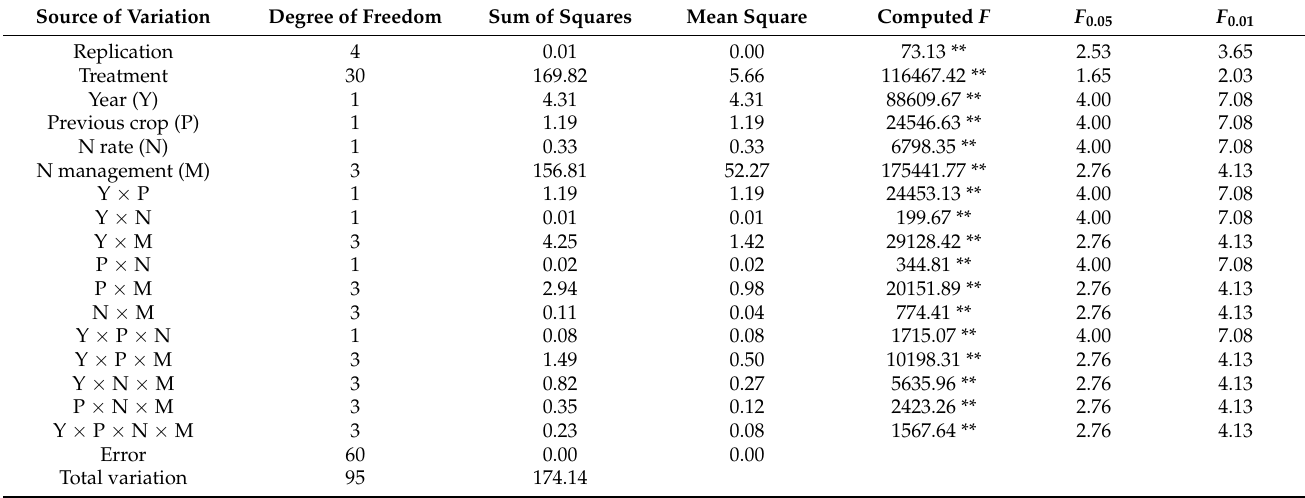
Table 1. Analysis of the variance of rice yield by nitrogen fertilizer management under a rapeseed/wheat–rice rotation sys-